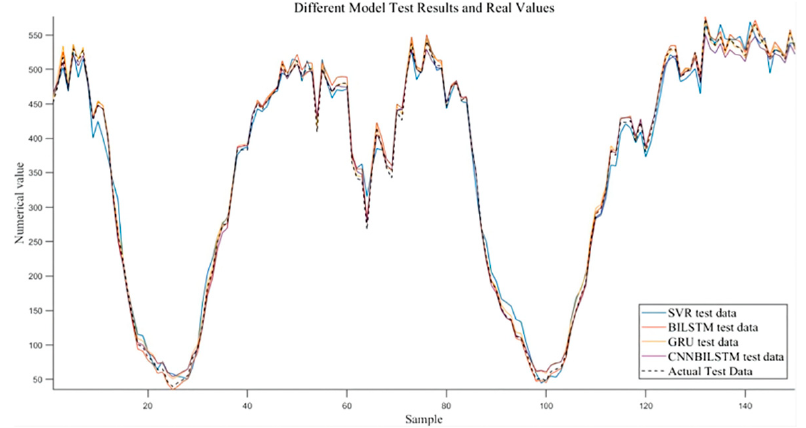
Figure 8. 5-minute forecast result graph.